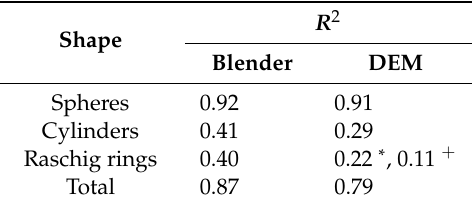
Table 6. Coe ffi cients of